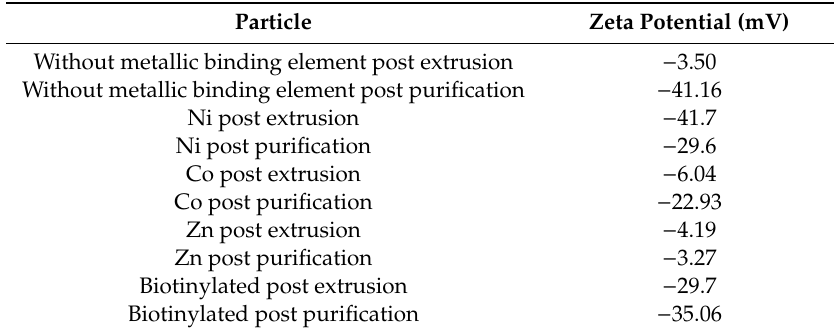
Table 3. Polysaccharide 19F encapsulated liposome surface